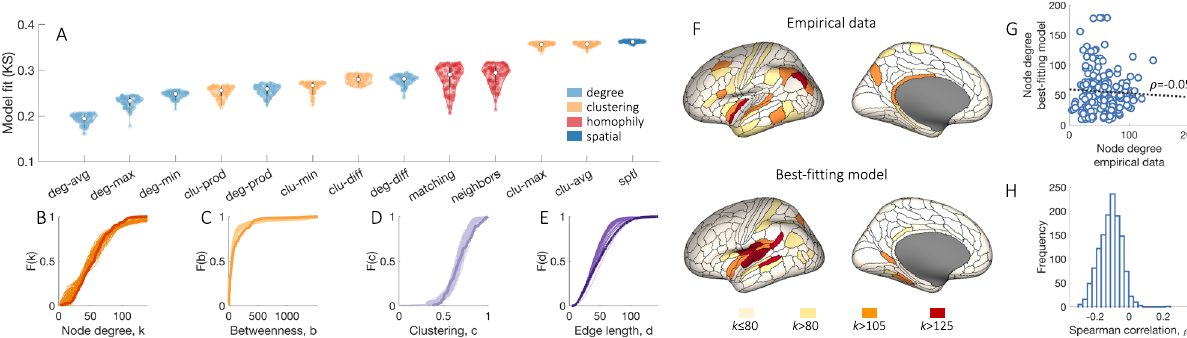
Fig. 4 Generative brain network models do not reproduce the spatial topography of brain network hubs. A Each distribution represents estimates of model fi t, as quanti fi ed by the maximum KS value of the top 100 networks (out of 10,000) produced by the model optimization procedure. The color of each box indicates conceptually related models, as determined by the speci fi c topology metric used in the model [Table 2]. White dots represent median values for each distribution. The interquartile range is represented with a dark gray box, whiskers are represented with a light gray line. Models favoring homophilic connectivity between node pairs are shown in red, those favoring clustering in orange, those based on the degree in light blue, and a purely spatial model considering wiring costs alone is in dark blue. The speci fi c wiring-rule names are shown along the horizontal axis, with formal de fi nitions provided in Table 2. Cumulative distributions of: B node degree, k ; C betweenness centrality, b ; D clustering coef fi cient, c ; and E edge length, d , for the empirical connectome (darker line) and 100 runs (lighter lines) of the best- fi tting “ deg-avg ” model corresponding to the data points shown in A . F Anatomical locations of hubs de fi ned for a single hemisphere at selected k thresholds for the empirical data (top) and the single run of the optimized “ deg-avg ” generative model demonstrating the best model fi t across 10,000 runs (bottom). G Correlation between the degree sequences of the empirical data and the best- fi tting generative model within a single hemisphere (Spearman ’ s ρ = − 0.05, p = 0.49). H The distribution of correlation values quantifying the relationship between left hemisphere degree sequences of the empirical data and synthetic networks generated using the top 100 best- fi tting parameter combinations for each of the 13 considered models, corresponding to the data points shown in A . Source data are provided as a Source Data fi